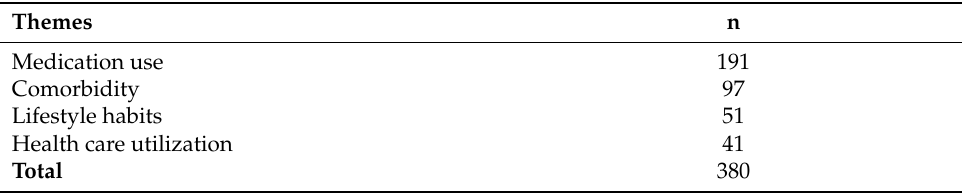
Table 2. Number of excerpts coded by